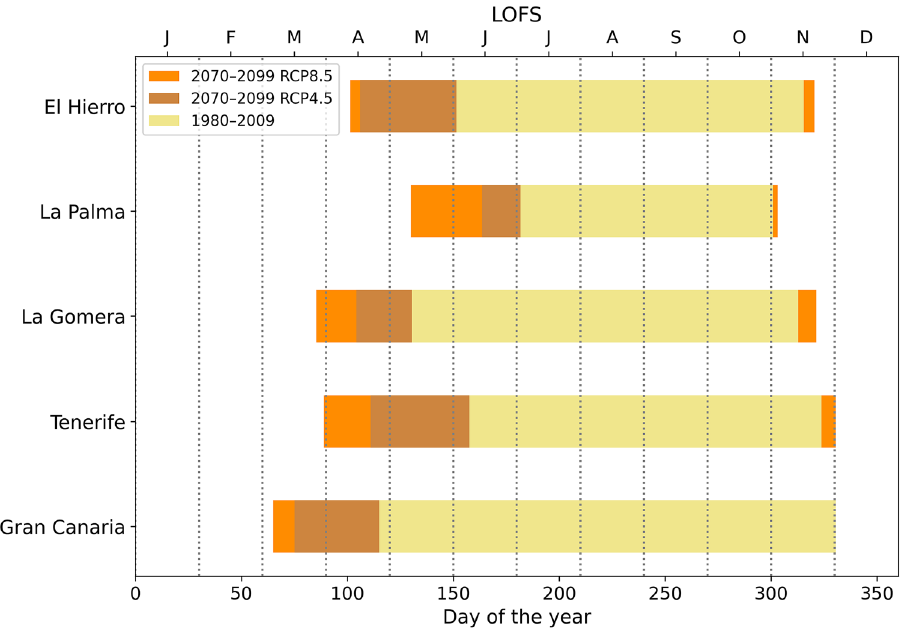
Figure 5. Length of the fire season (days) for different islands, indicated by the length of the horizontal bars. The vertical grid lines facilitate the identification of the initial and final day of the season in each period: recent past, 1980–2009 (beige), and future, 2070–2099, RCP4.5 (brown), 2070–2099, RCP8.5